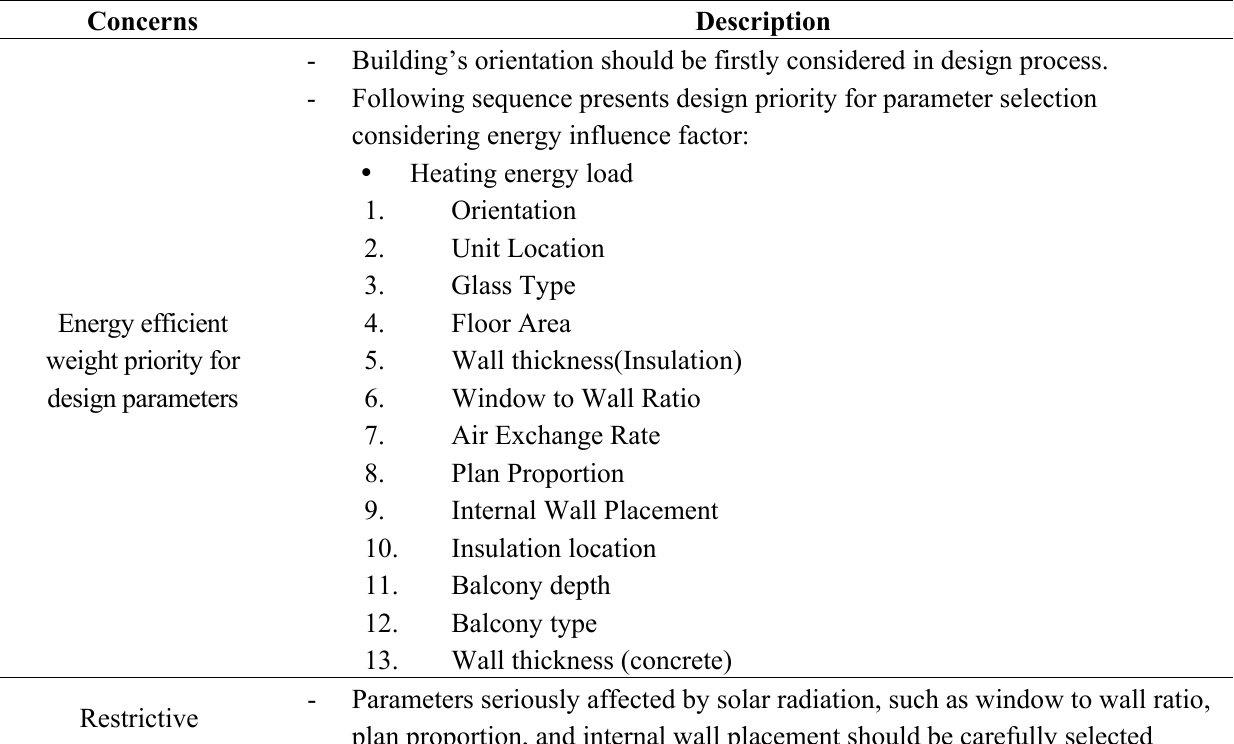
Table 16. Energy efficiency weight and restrictive conditions for design decision model.